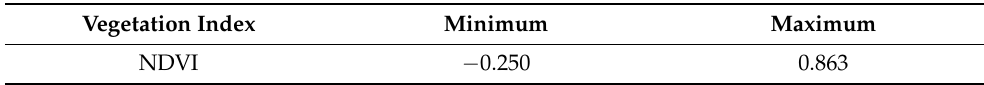
Figure 10. NDVI map analyzed by UAV-based multispectral image. Table 5. Statistical value of NDVI map.